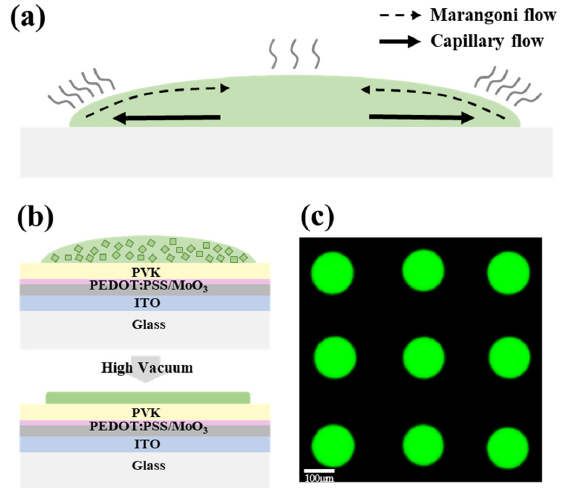
Figure 2. ( a ) The drying process of a single perovskite nanocrystal droplet on substrate; ( b ) schematic of a perovskite dot array on a multilayer (PVK/PEDOT:PSS/MoO3/ITO/Glass) substrate, the samples of which were then transferred to a high vacuum chamber to remove solvent; ( c ) image of the uniform, printed perovskite nanocrystal dots array under optical microscope with an excitation light of 365 nm. The scale bar is 100 μ m.